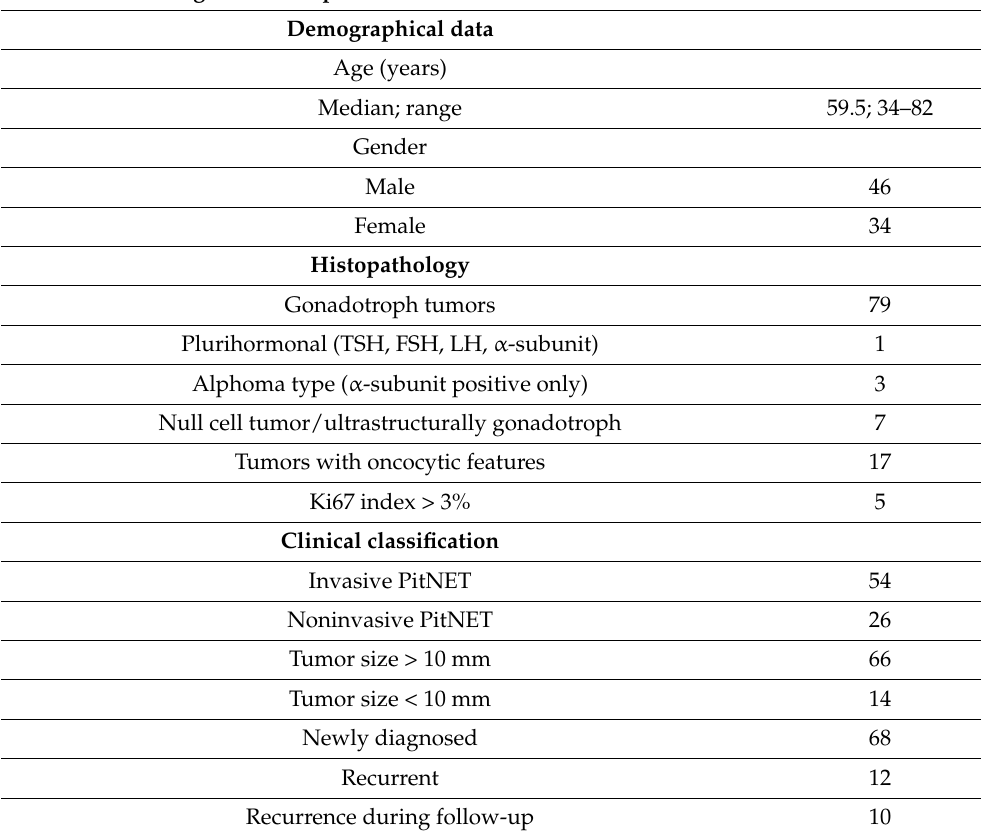
Table 1. Pituitary Tumor Patients’